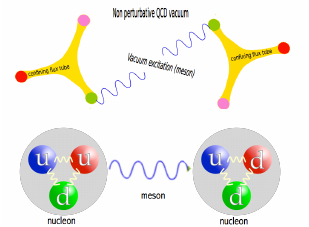
Figure 1: Mechanism of NN interaction in the QMC model (top) and in traditional RMF models which ignore the internal structure of the baryons (bottom). Adapted from Ref. [3] under Creative Commons Attribution